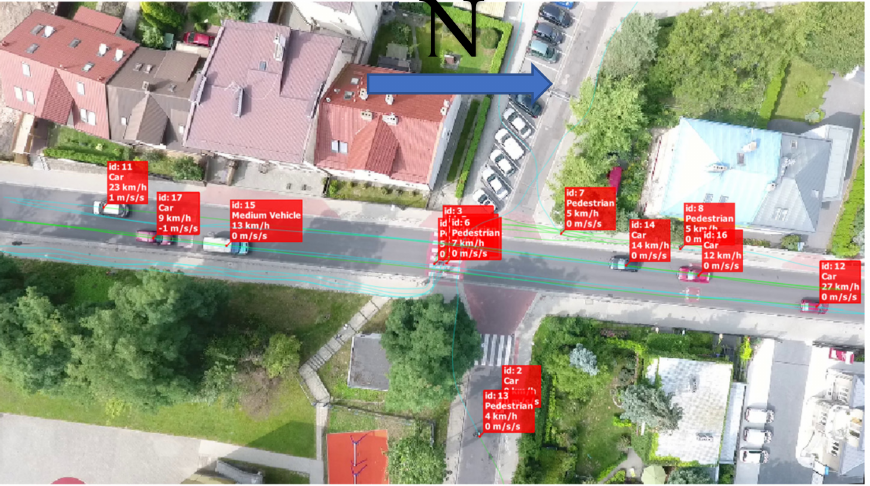
Figure 6. DatafromSky viewer software screenshot with car detection and trajectory data displayed (source: own).